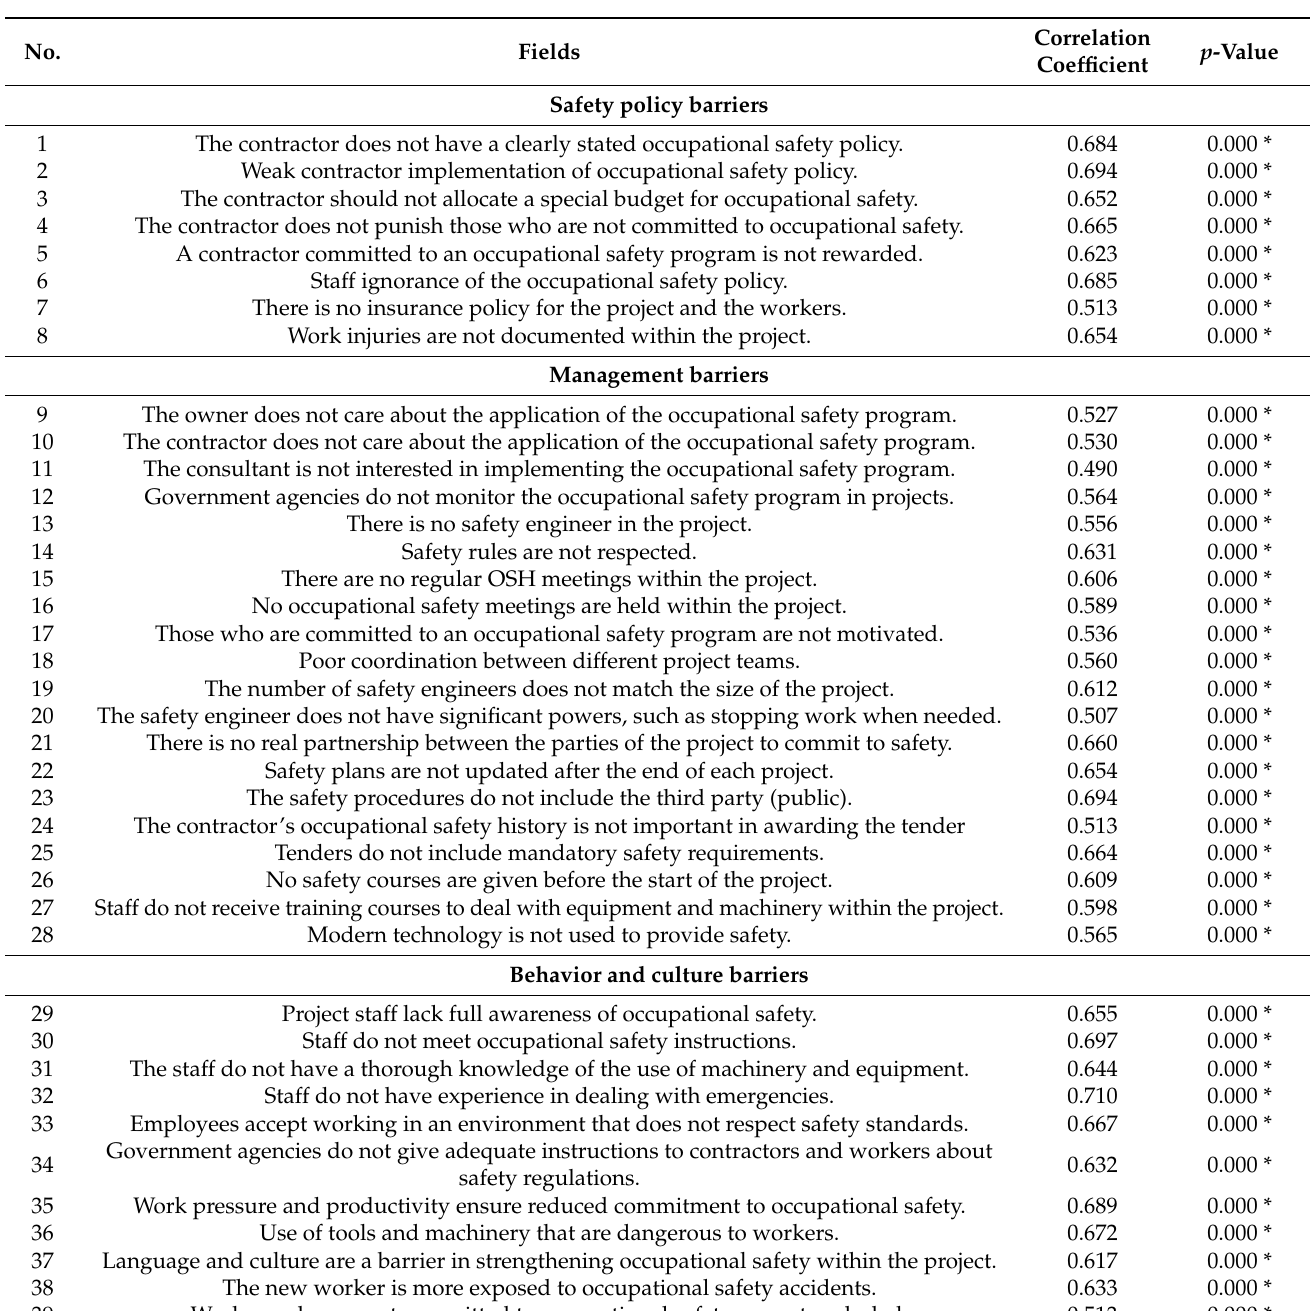
Table 2. Internal validity of barriers that hinder the implementation of safety practices in the infrastructure sector. No. Fields